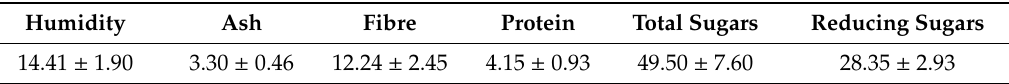
Figure 2. Particle size distribution of the as-received carob pod. Table 3. Chemical analysis of the carob pod. The results are expressed as %w/w.